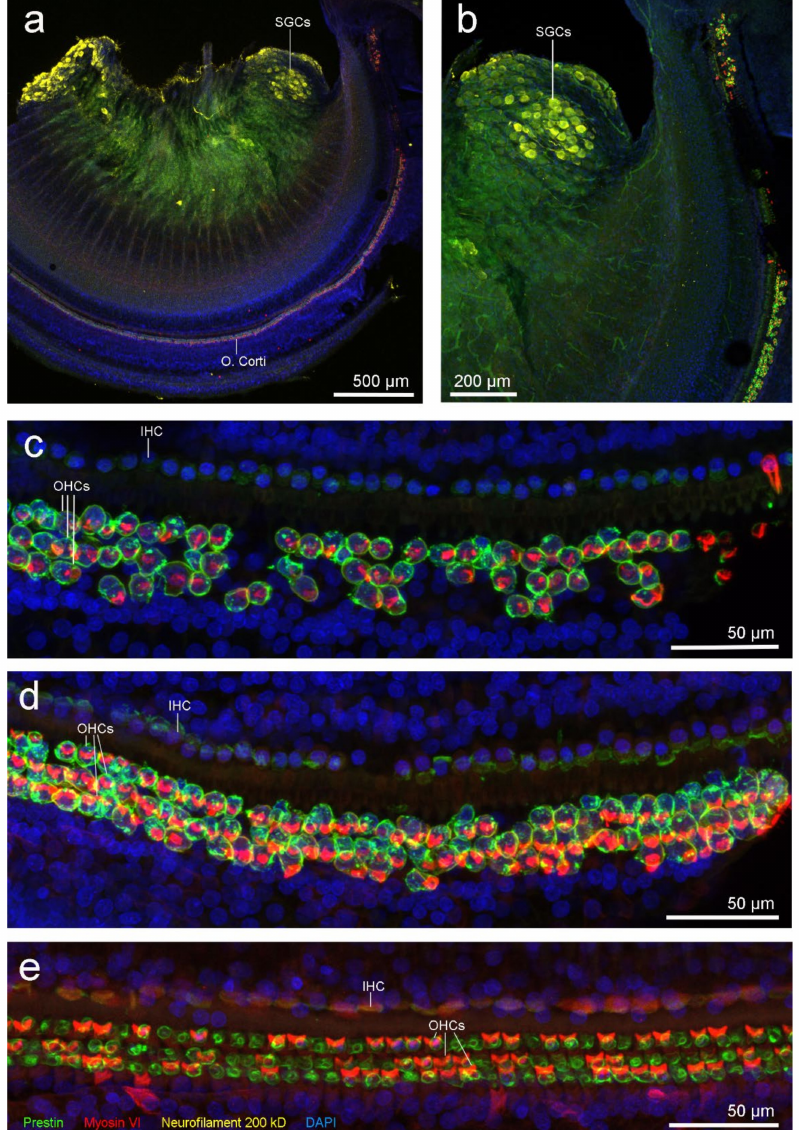
Figure 3. Immunofluorescence micrographs of the right cochlea from individual UT1535, labelled with anti-prestin (green), anti-myosin VI (red) and anti-neurofilament 200 kD (yellow) antibodies and DAPI (blue). ( a – d ) Apical turn; note the missing outer hair cells (OHCs) in ( c ) and a few OHCs missing from the third row in ( d ). ( e ) Organ of Corti of the lower apical turn. All these micrographs are z-projections from confocal images, whose slice thicknesses were 75 µ m ( a ), 10 µ m ( b ) and 1.5 µ m ( c – e ). IHC, inner hair cells; O. Corti, organ of Corti; SGCs, spiral ganglion